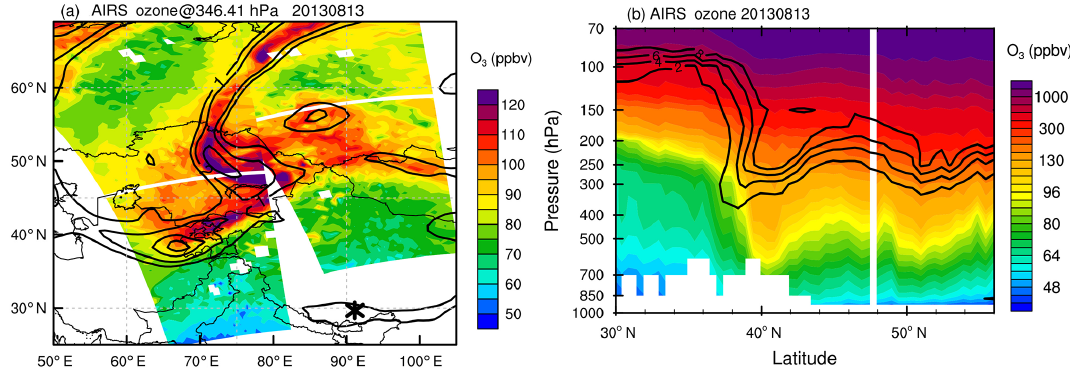
Figure 8. (a) Ozone volume mixing ratio for 346.41hPa on 13 August at about 06:00UTC from the AIRS satellite. (b) Latitude–pressure cross section of ozone along 70 ◦ E with PV (2, 4, 6, and 8PVU, black